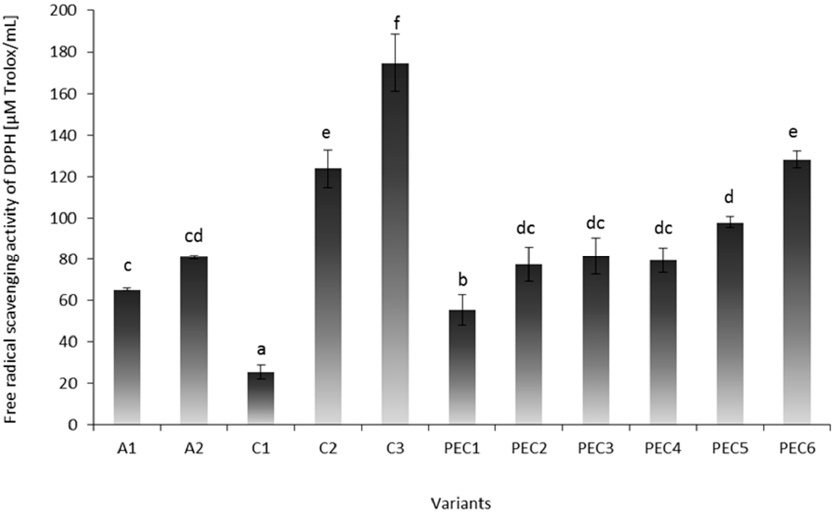
Figure 1. The antioxidant activity of sodium alginate (A1, A2), chitosan (C1, C2, C3), and polyelectrolyte complex (PEC1-PEC6) hydrosols determined by free radical scavenging of DPPH. Values with different letters (a–f) differ significantly ( p < 0.05), n = 3.